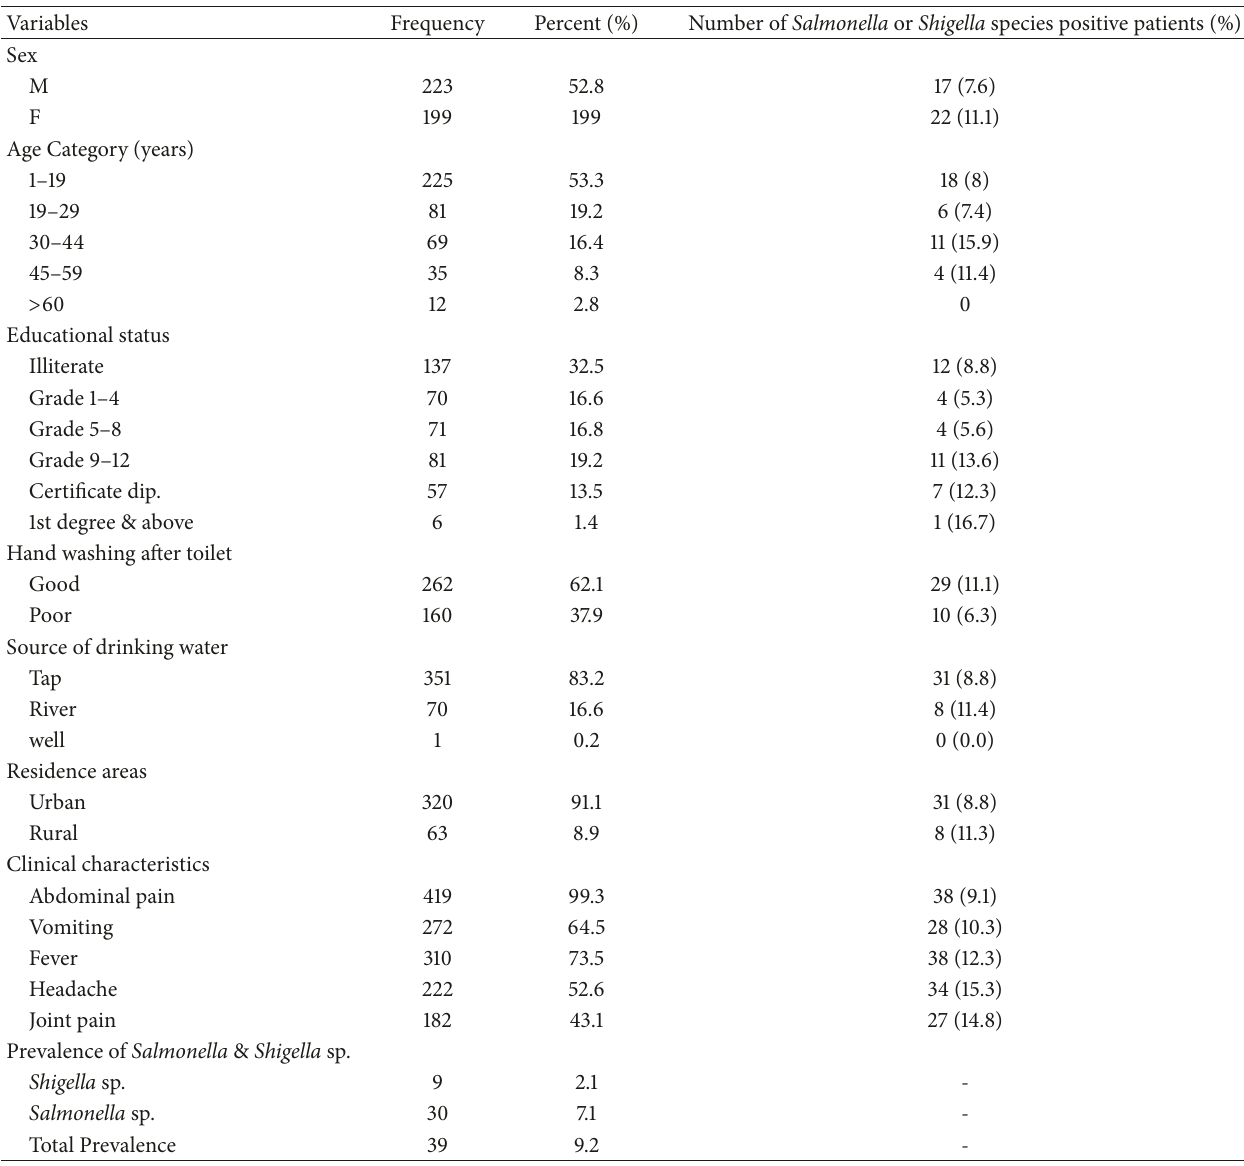
Table1:Sociodemographic,clinicalcharacteristics,andprevalenceof Salmonella and Shigella